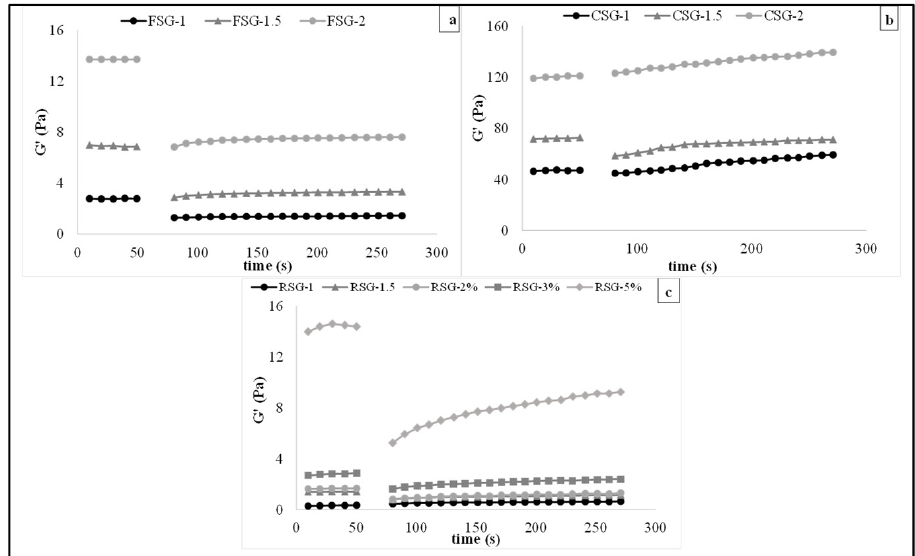
Figure 5. 3-ITT rheological properties of CSG: chia seed byproduct gum, FSG: flaxseed byproduct gum, RSG: rocket seed byproduct gum solutions with different concentrations (( a ) CSG (1–2%), ( b ) FSG (1–2%), ( c ) RSG (1–5%)).